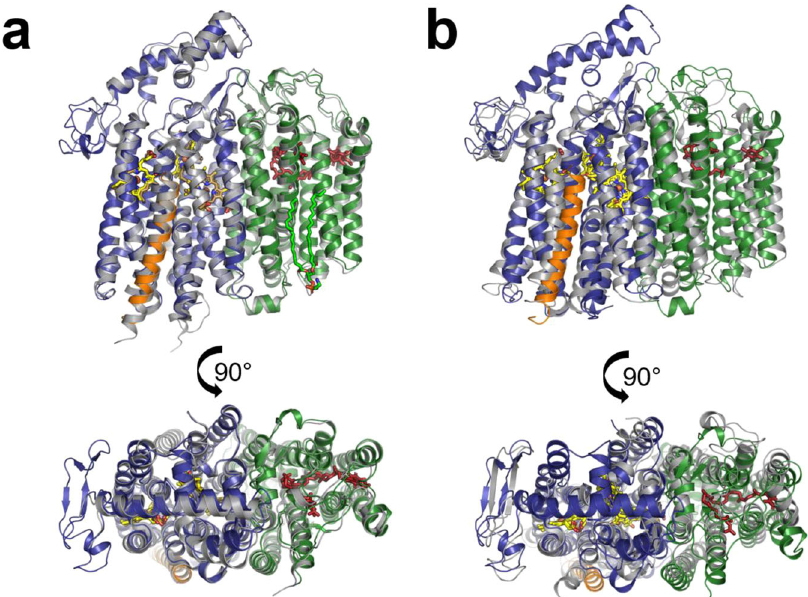
Fig. 5 Superposition of bd -II with bd -I and G. thermodenitri fi cans bd oxidase. a Superimposed structure of E. coli bd -II and E. coli bd -I and b of E. coli bd -II and G. thermodenitri fi cans bd oxidase. Subunit AppC is shown in blue, AppB in green and AppX in orange. The homologous subunits of E. coli bd -I and G. thermodenitri fi cans bd oxidase are all shown in gray. The heme groups are shown in yellow and ubiquinone-8 in red.